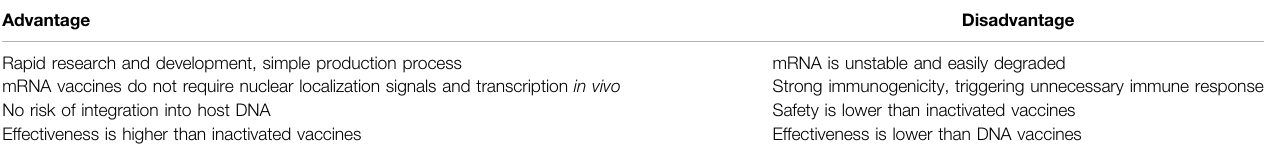
TABLE 1 | Advantages and disadvantages of mRNA vaccines.